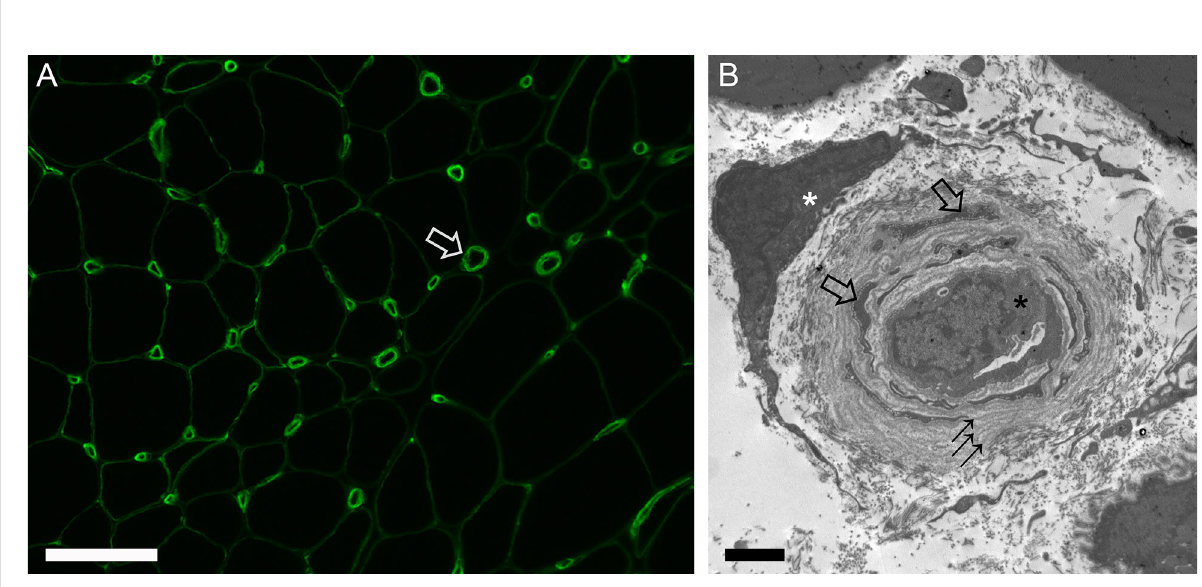
FIGURE 1 Capillary pathology in scleromyositis. (A) Immuno fl uorescence for collagen type 4 highlighting enlarged endomysial capillaries often with laminated appearance of basement membrane (open arrow). (B) Electron micrograph showing a collapsed capillary (black asterisk) with several concentric layers of reduplicated basement membrane (arrows) ensheathing many pericyte processes (open arrows). A fi broblast is also shown (white asterisk). Bars: A, 100 µm, B, 2